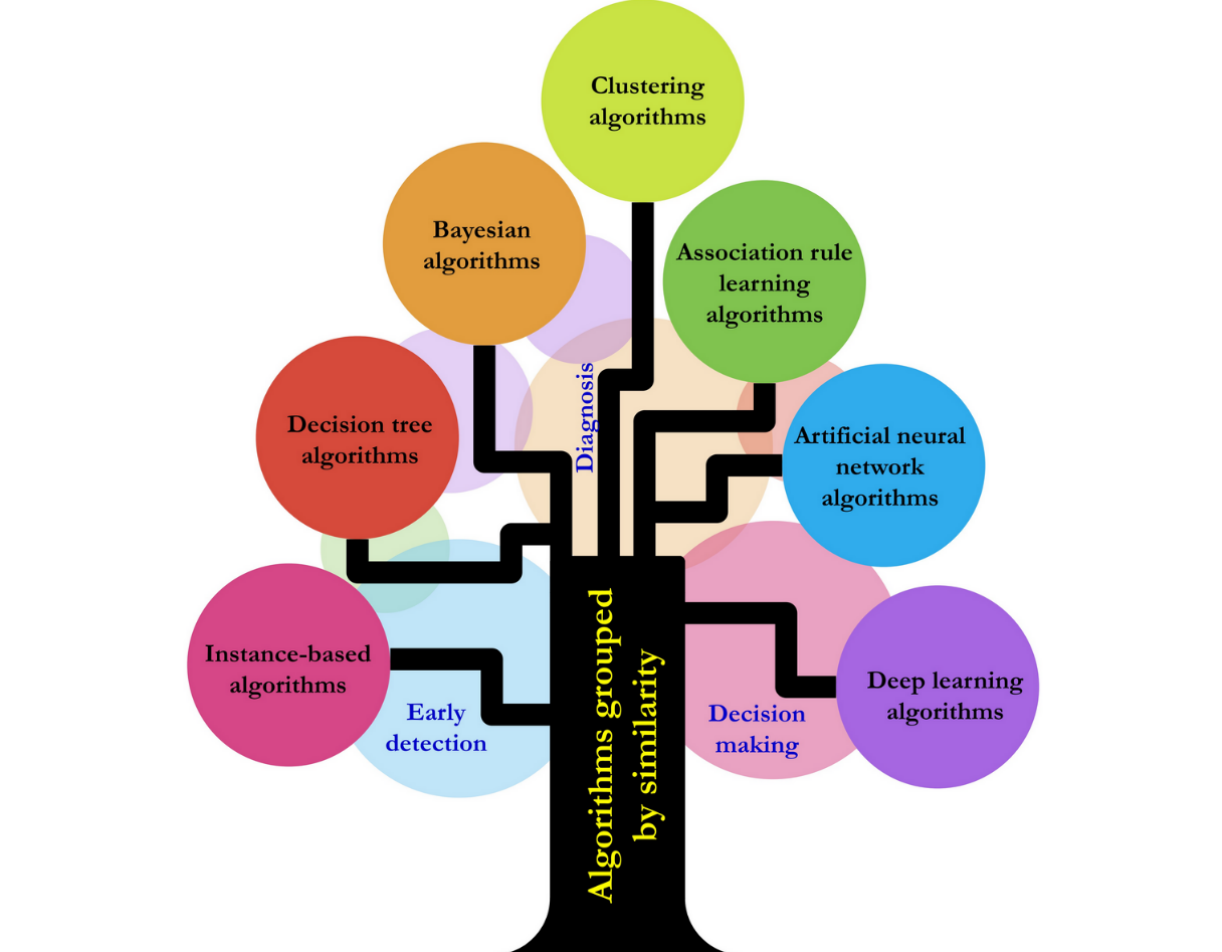
Figure 5. Artificial intelligence algorithms for independent